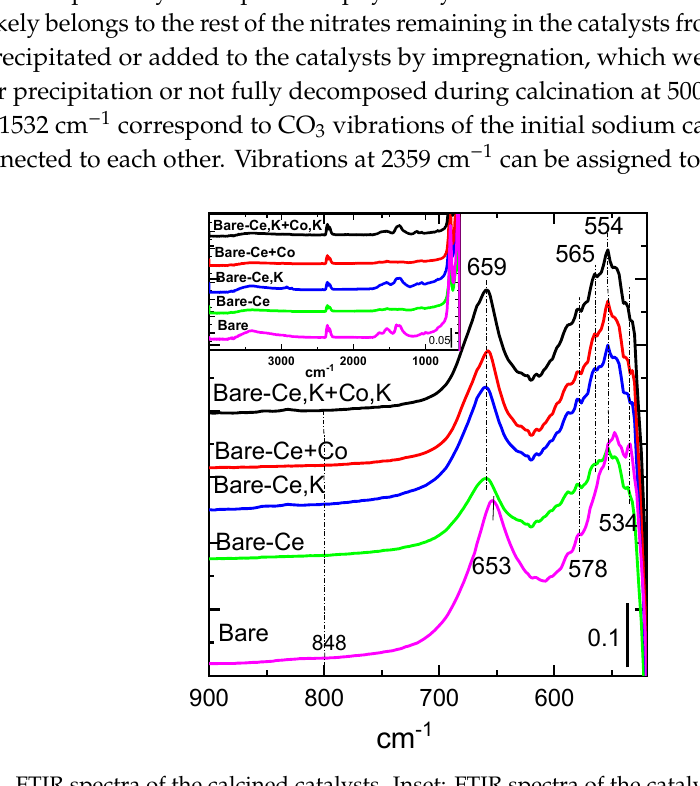
Figure 4. FTIR spectra of the calcined catalysts. Inset: FTIR spectra of the catalysts in the range of 900 to 4000 cm − 1 .